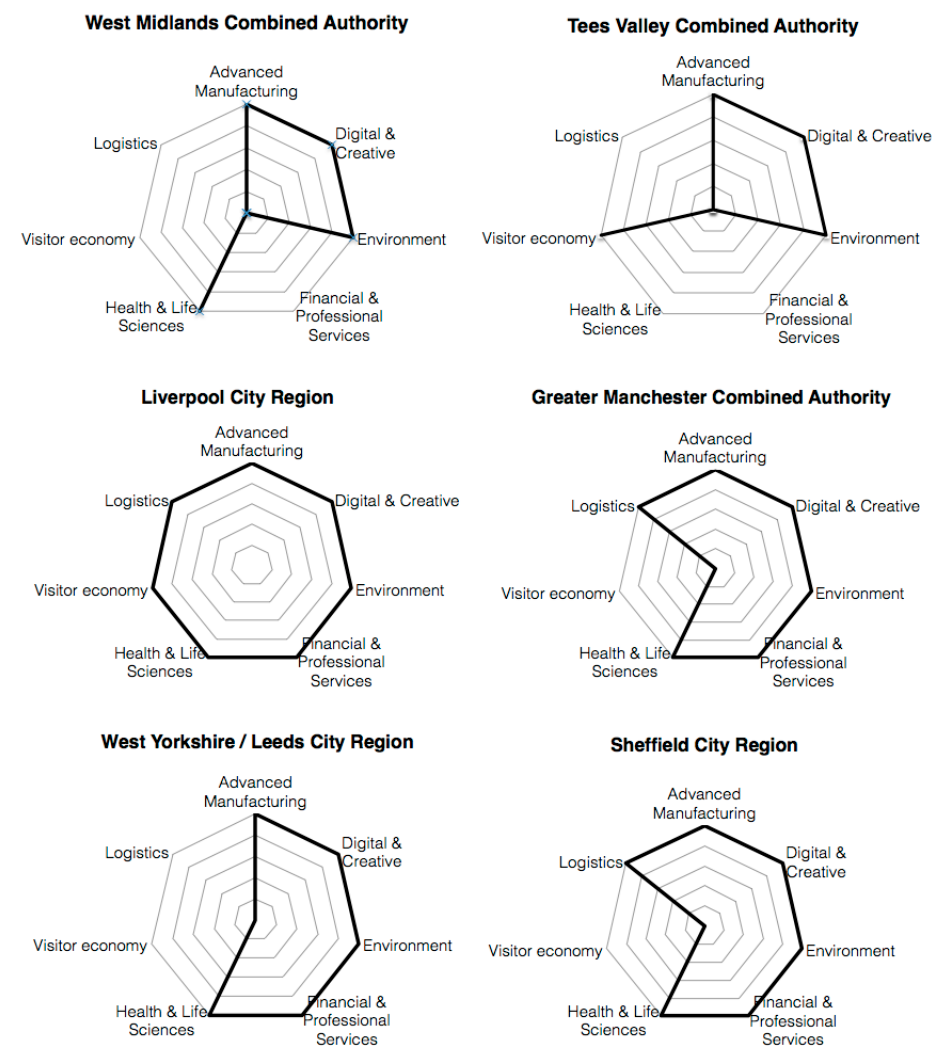
Figure 3. Sectoral policy focus areas for six selected city regions/combined authorities.